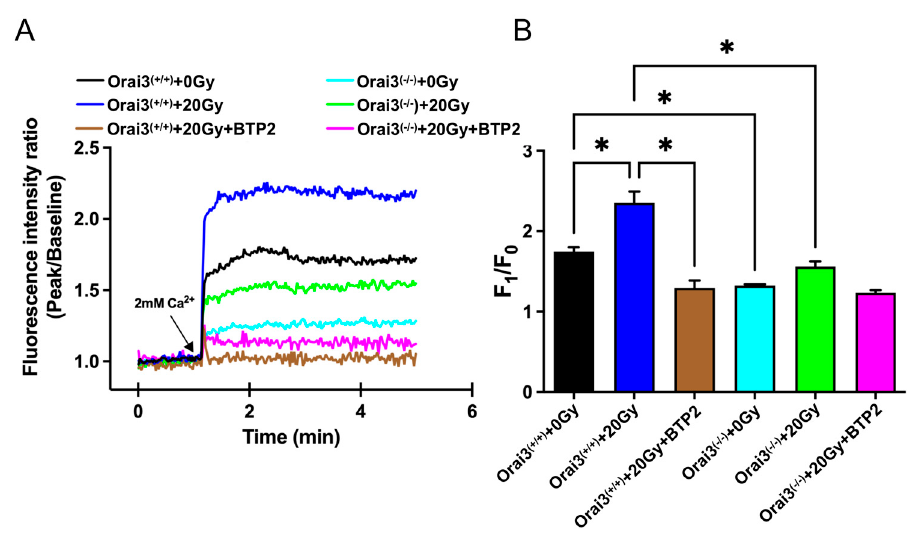
Figure 2. Effect of X-ray irradiation on store-operated Ca 2+ entry (SOCE) in rat brain microvascular endothelial cells (rBMECs). ( A , B ) Representative traces ( A ) and summary data ( B ) showing thapsigargin (TG) -evoked SOCE in rBMECs derived from wild-type Orai3 (+/+) rats 24 h after cells were unexposed (0 Gy) or exposed (20 Gy) to X-ray irradiation and untreated or treated with BTP2 (5 µ M); and in rBMECs derived from rats with Orai3 knockout (Orai3 ( − / − ) )unexposed (0 Gy) or exposed to X-ray irradiation (20 Gy) and untreated or treated with BTP2 (5 µ M). After cellular Ca 2+ stores were depleted by the application of 2 µ M TG for 10 min in Ca 2+ -free medium, SOCE was evoked by application of 2 mM Ca 2+ to the cell culture medium. Data are shown as the mean ± SEM ( n = 3), * p < 0.05 analyzed by one-way analysis of variance followed by Dunnett’s multiple comparisons test.